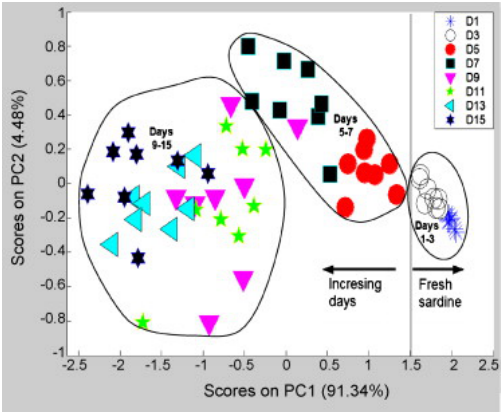
Figure 1. Scores plot of a PCA on sardine data using the six-element gas sensors array. A vertical line separating fresh samples from medium and aged ones and ellipses grouping fresh, medium and aged samples had been added for easy identification (reprinted from [29] with permission from Elsevier, copyright